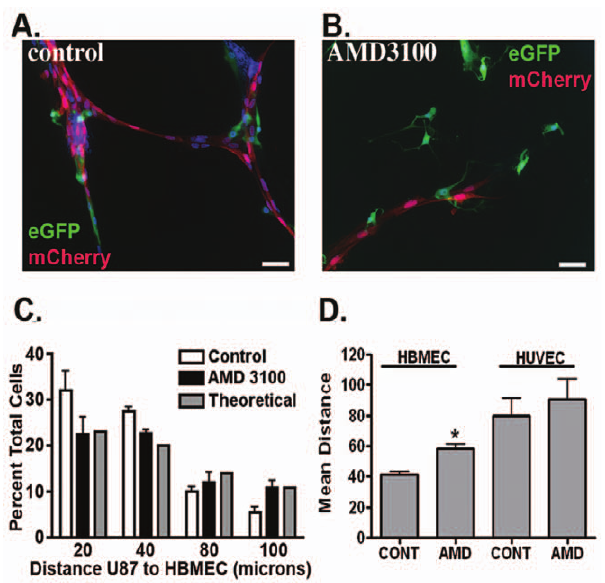
Figure 5. U87 localization to the peri-endothelial space is blocked by the CXCR4 antagonist AMD 3100. ( A ) GFP-expressing U87 cells (green) are localized to mCherry-expressing HBMECs (red). ( B ) Treatment of parallel co-cultures as in A with AMD 3100 results in failure of U87 cells (green) to make consistent contact with endothelial cells (red). Scale bar equals 25 microns. ( C ) The CXCR4 antagonist AMD 3100 redistributes U87 cells, decreasing the number of cells within the nearest proximity to HBMECs and increasing the number of cells at greater distance. *=p , 0.05 as determined by two-way ANOVA. ( D ) AMD 3100 increased the mean distance between U87 cells and HBMECs but had no effect on the mean distance between U87 cells and HUVECs. *=p , 0.05 as determined by two-tailed t -test.